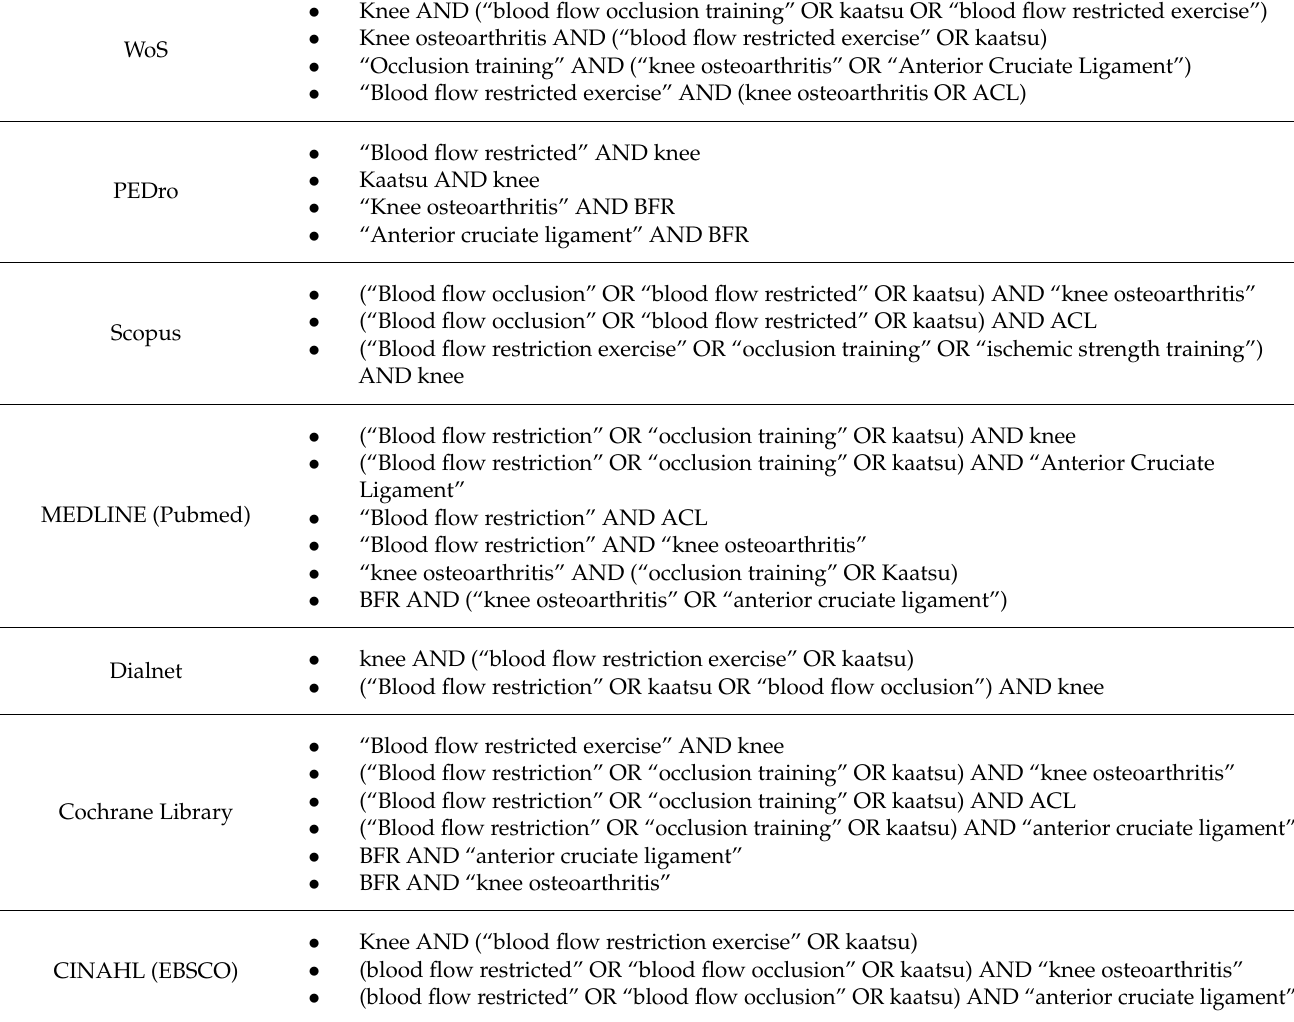
Table A1. Research